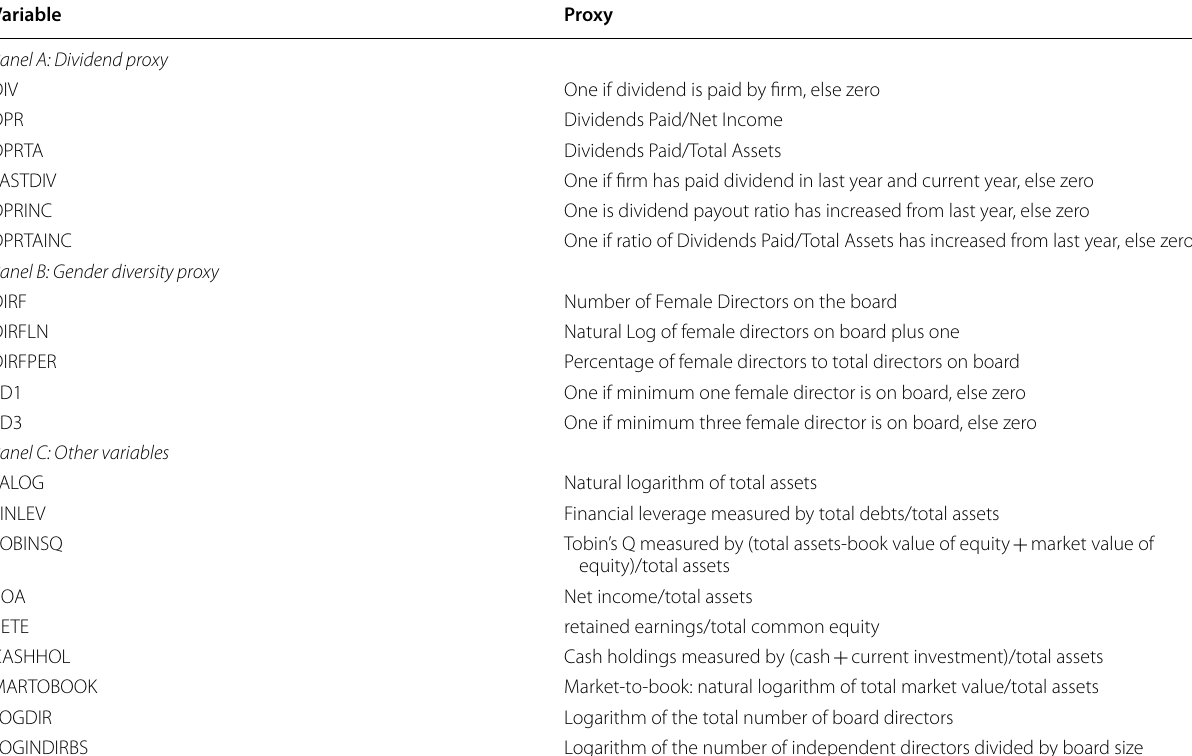
Table 1 Variables description